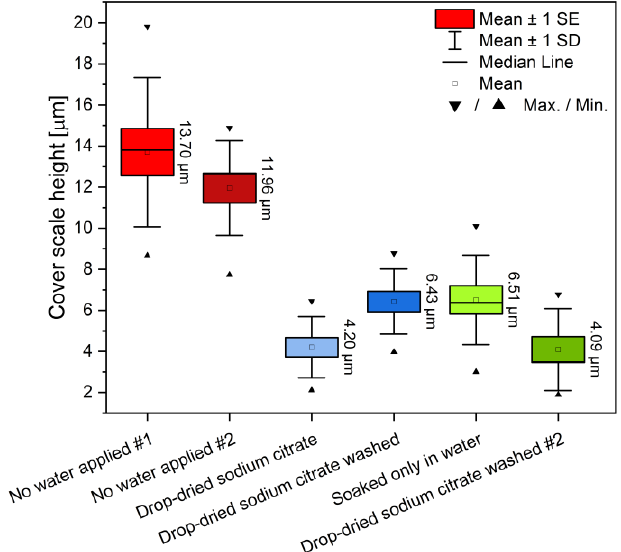
Figure 9. Height of the cover scales with respect to the wing plane as measured by a focus stacking microscope. After the citrate treatment, the height of the terminal region of the cover scales is reduced to about half of the pristine value. This indicates that the scales are flattened towards the wing membrane after the sodium citrate treatment.